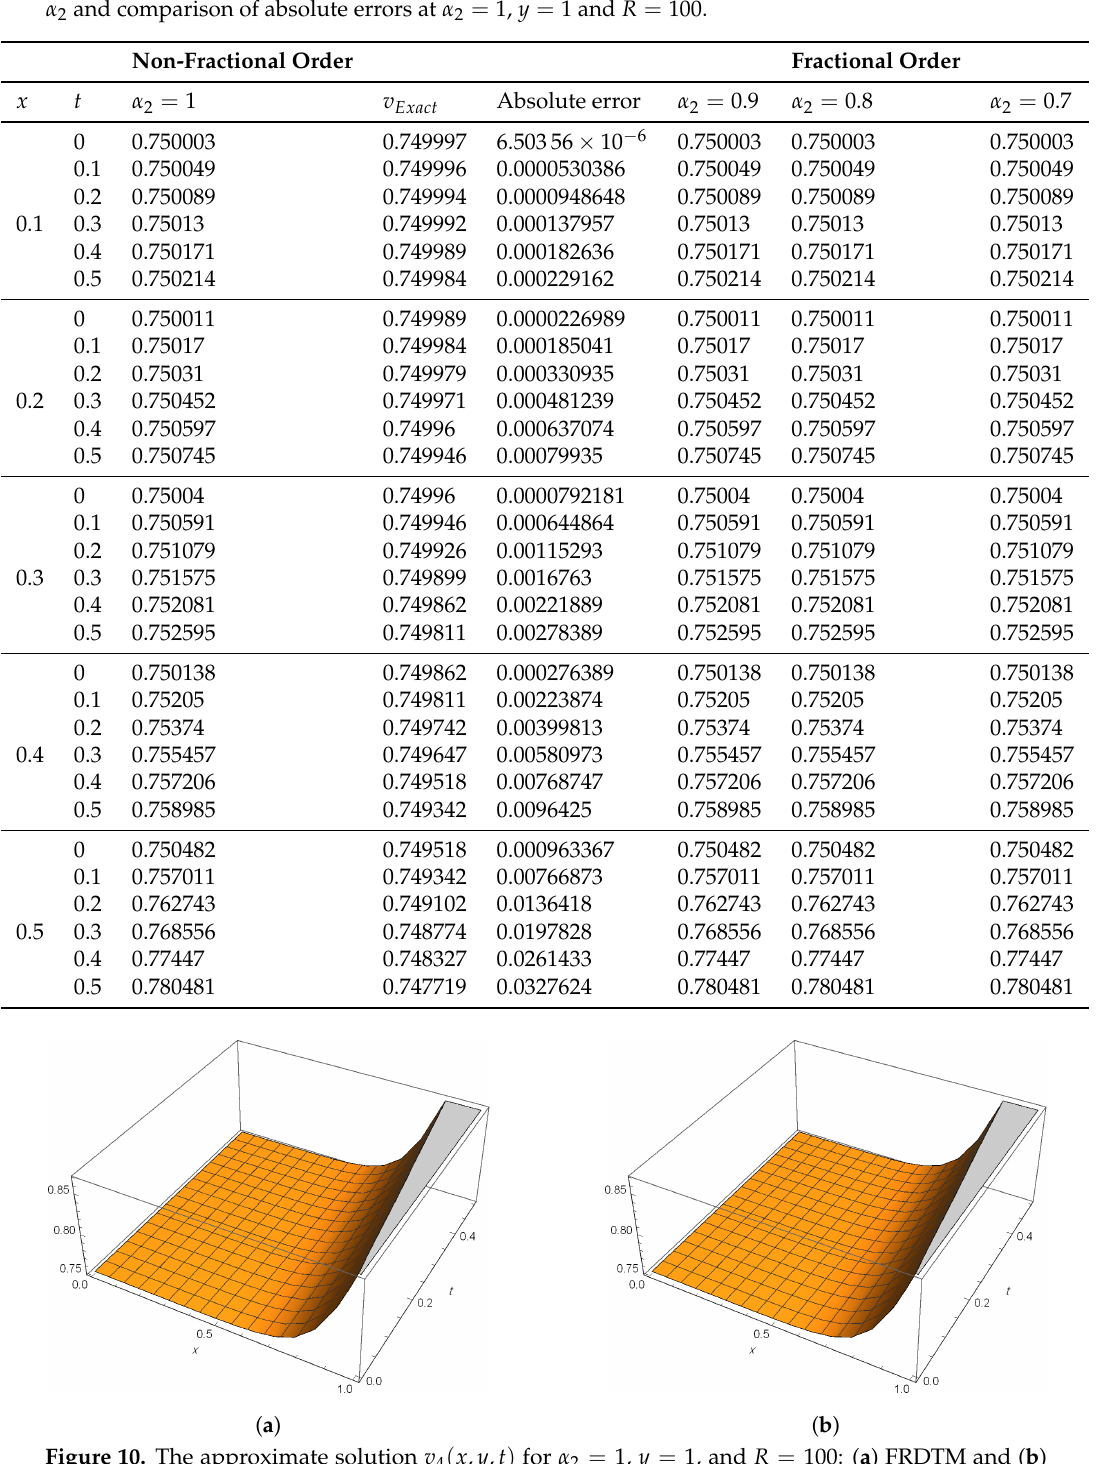
Figure 10. The approximate solution v 4 ( x , y , t ) for α 2 = 1, y = 1, and R = 100: ( a ) FRDTM and ( b ) exact